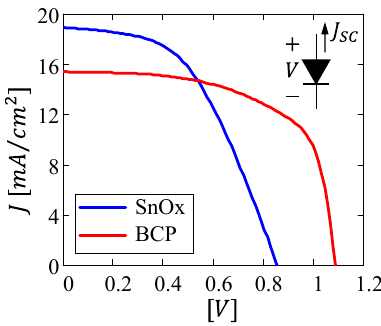
Figure 2. Illuminated current vs voltage characteristics for the SnO X (blue line) and BCP (red line) architectures measured at the beginning of the characterization procedure. Table 1. Solar cell figures of merit extrapolated at the beginning of the characterization procedure. Architecture